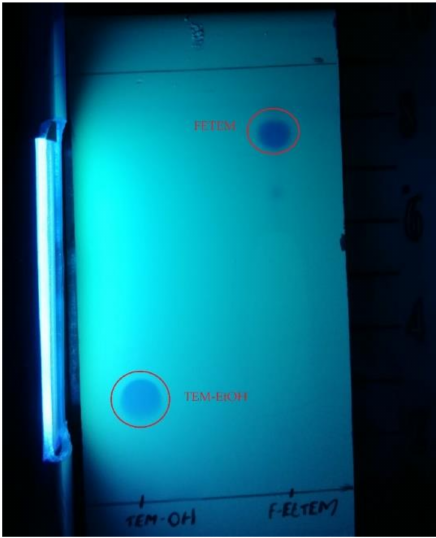
Figure 5. TLC analysis of standards FETEM and TEM-EtOH, detection in UV light at 254 nm.